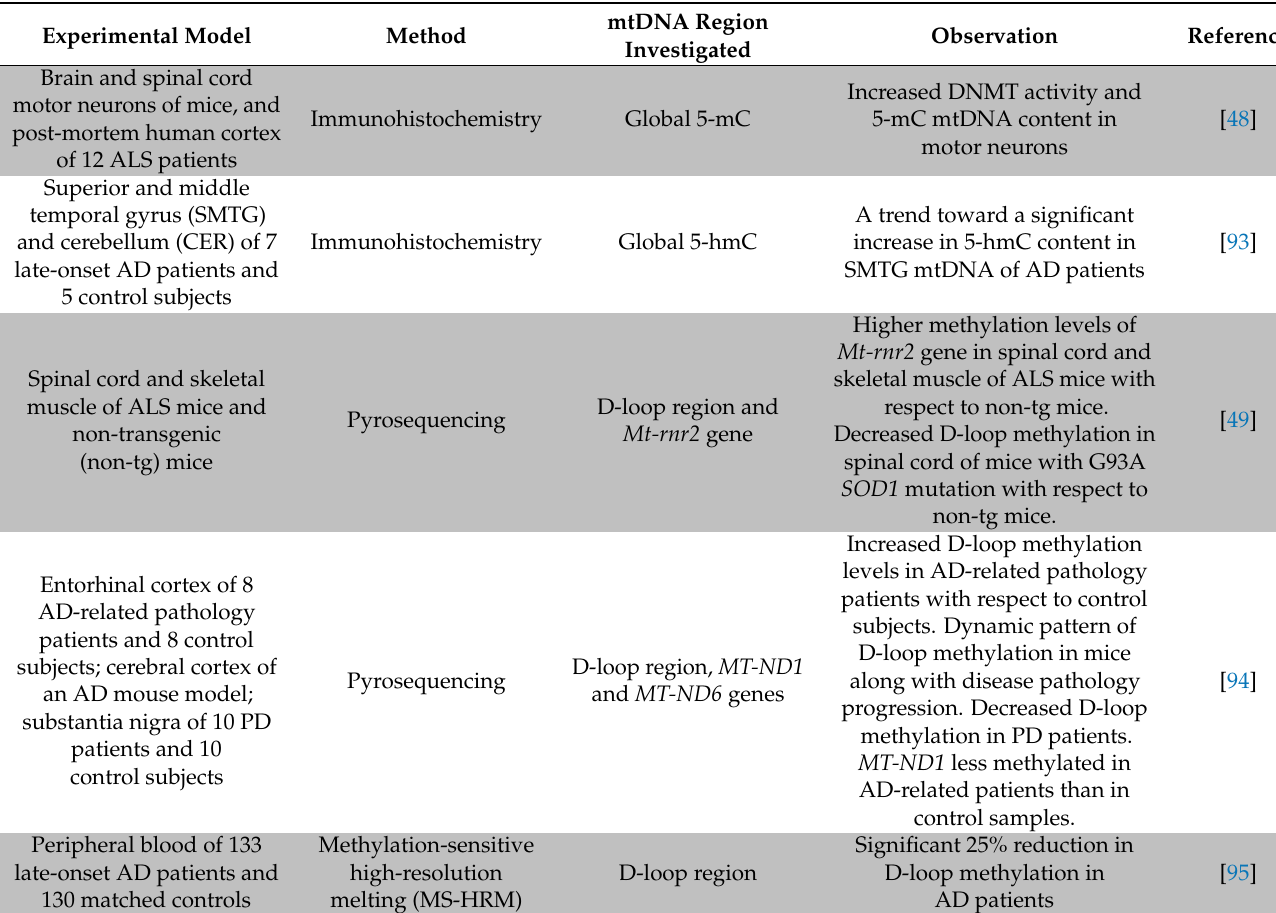
Table 4. mtDNA methylation studies in neurodegenerative